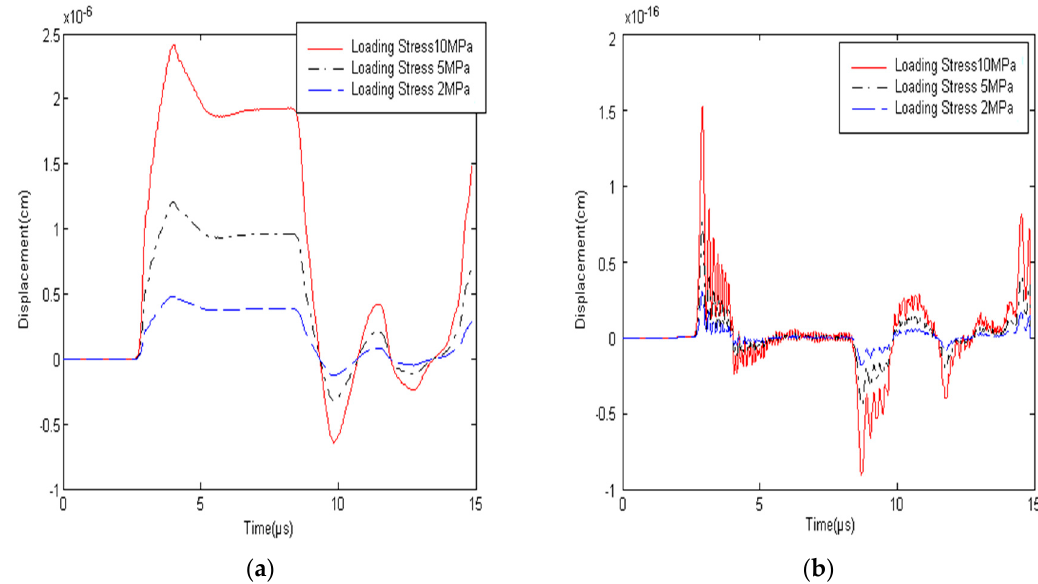
Figure 17. The displacement of a point at the crack tip of phonon field ( a ) and phason field ( b ).